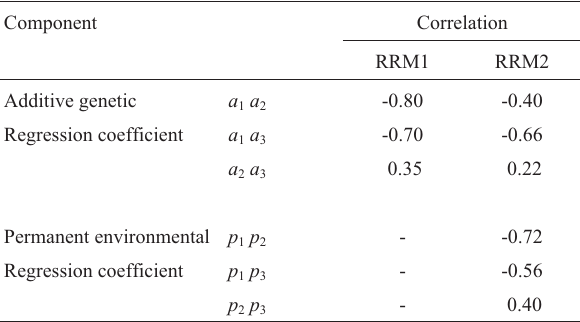
Table 5 - Estimates of genetic and permanent environmental correlations between the random regression coefficients obtained by the RRM1 and RRM2 models.